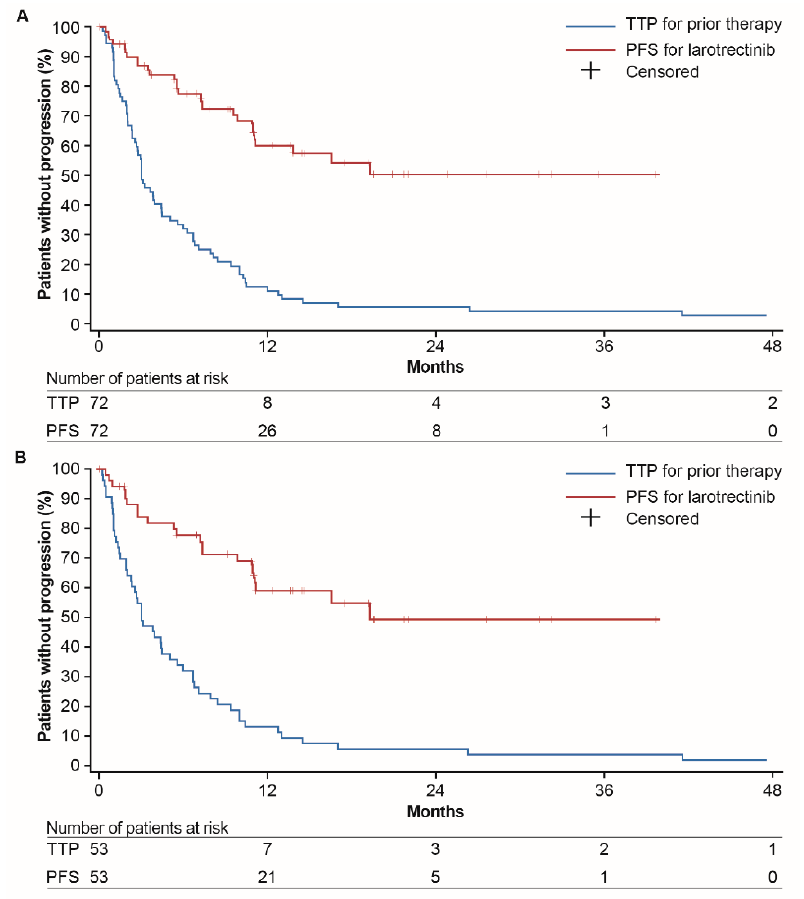
Figure 1. Kaplan–Meier plot of progression-free survival on larotrectinib (per IRC) and time to progression on the previous line of therapy (per investigator assessment) for ( A ) the overall dataset (locally advanced or metastatic disease ( n = 72)) and ( B ) patients with metastatic disease ( n = 53). For TTP, one patient was censored at 122 months and one patient had progressed at 151 months. Abbreviations: IRC, independent review committee; PFS, progression-free survival; TTP, time to progression.